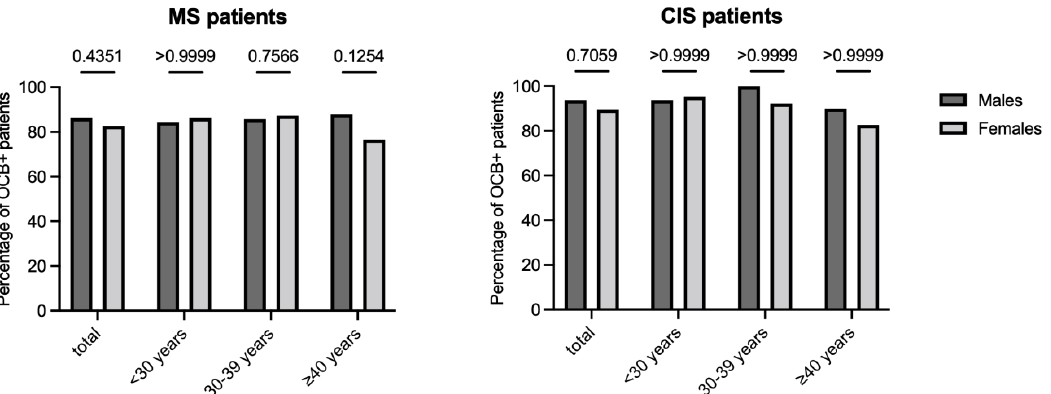
Figure 2. Impact of sex and age on the qualitative determination of an intrathecal IgG synthesis (IIS). The “gold standard” of the cerebrospinal fluid (CSF)-restricted IgG oligoclonal bands (OCB) was used to assess the presence of an IIS. Multiple sclerosis (MS) subjects (cohort 1 and cohort 2 together) and patients with the clinically isolated syndrome (CIS) (cohort 3) were both analyzed as a whole and grouped by age. Fisher's exact test was used for all comparisons.